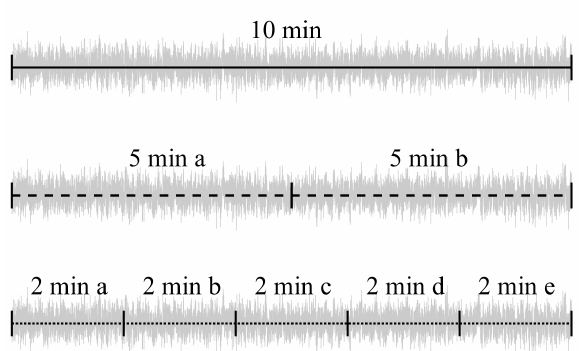
Figure 2. Subdivision in time segments of the original 10 min time